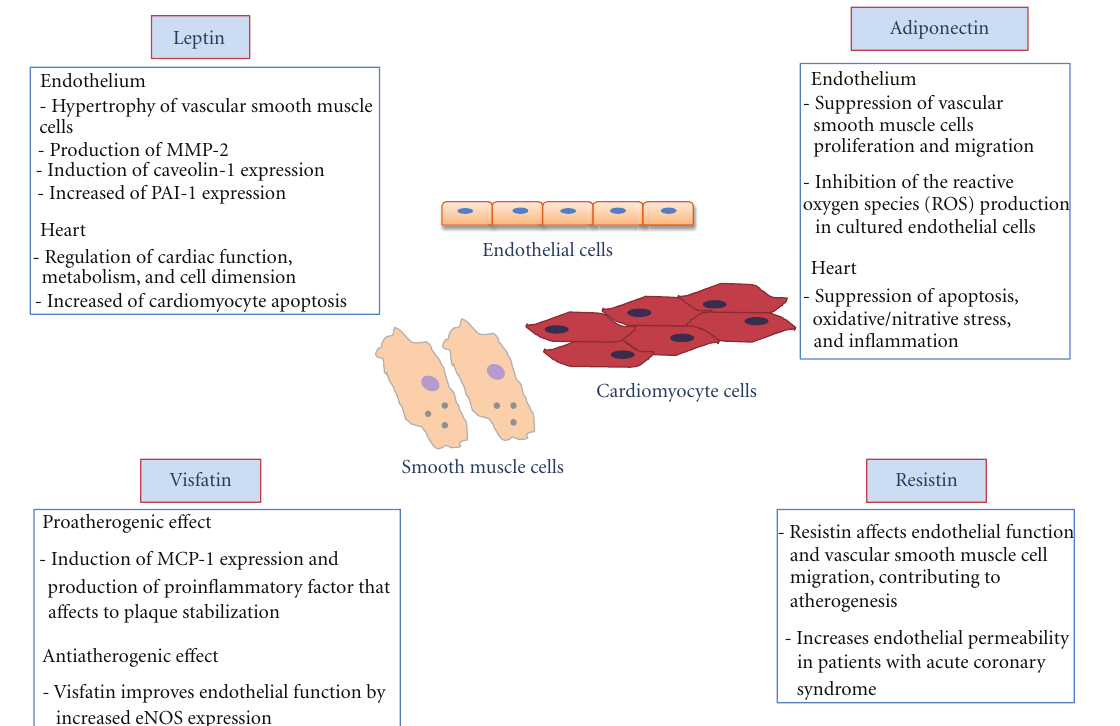
Figure 1: Schematic representation of the involvement of leptin, adiponectin, resistin, and visfatin in atherosclerosis.